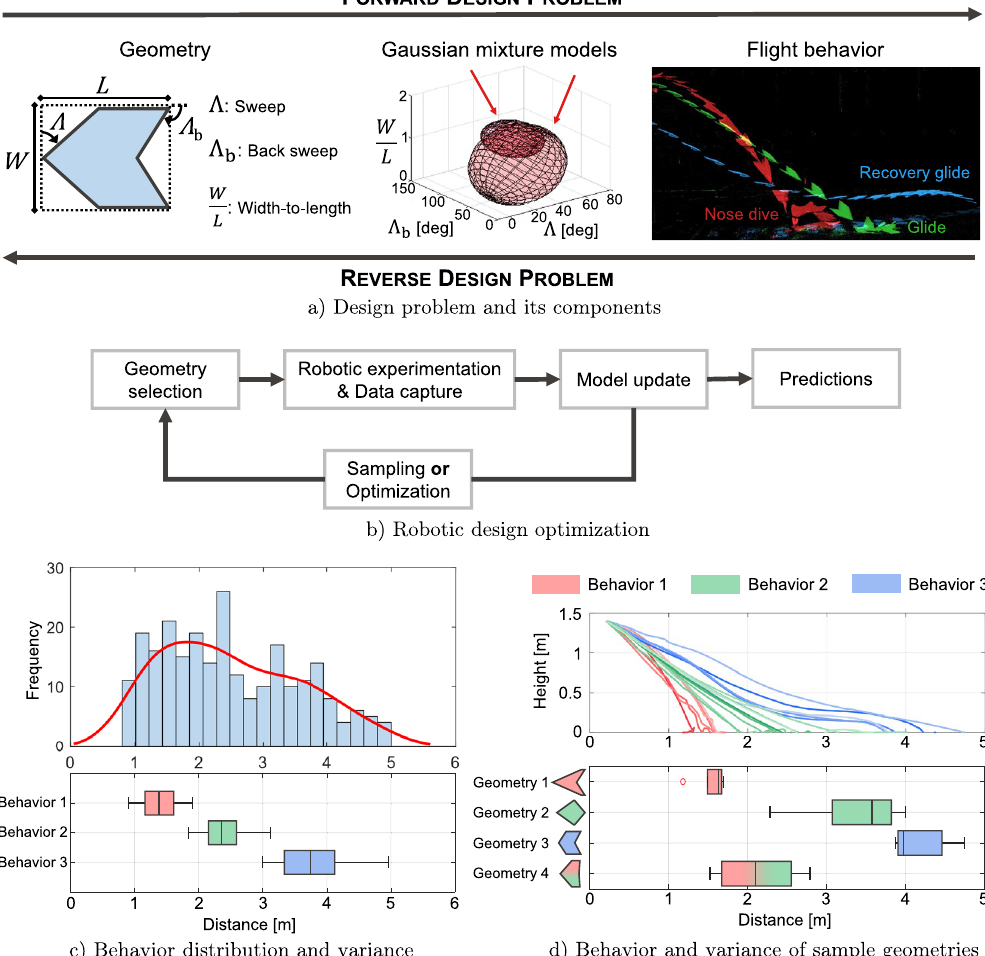
Figure 1. ( a ) Summary of our design problems leveraging cluster-based mixture models. In forward design, flight behavior is predicted for a given airplane geometry and in reverse design, the geometry is predicted given a target flight behavior. ( b ) Summary of our proposed geometry sampling and optimization using a robot designer. ( c ) Flight behavior distribution and variance for the whole design space of paper airplanes. ( d ) Flight behavior and variance of four sample geometries and their cluster-based behavioral